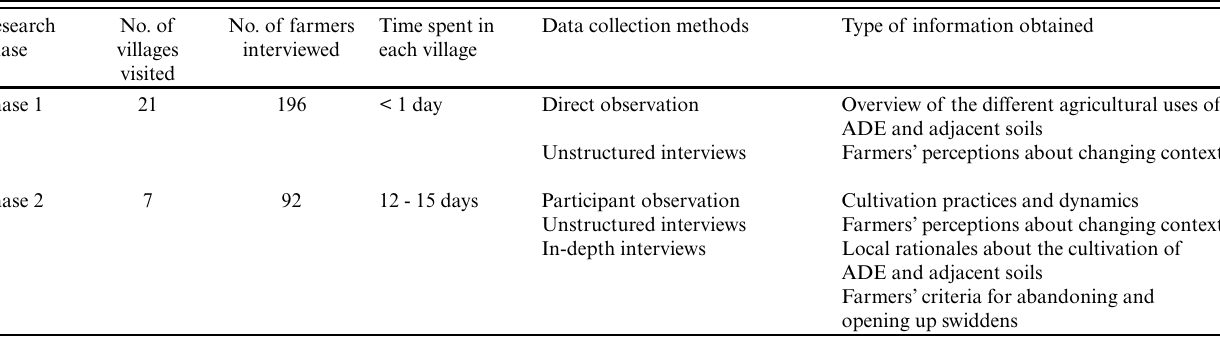
Table 1 . Summary of the sampling design, the data collection methods used and the type of information obtained in the two phases of the research. ADE = Amazonian dark